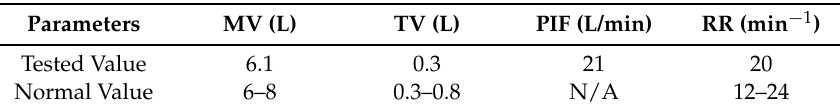
Table 1. Tested respiratory parameters.